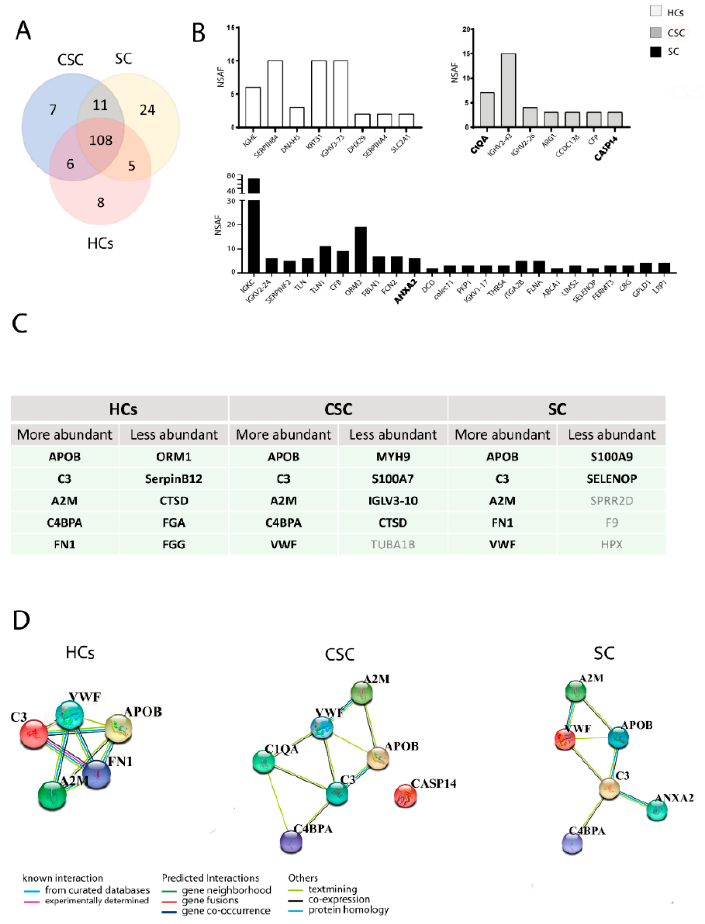
Figure 2. Significant proteins in the serum-derived EVs from healthy controls and patients with ischaemic stroke: ( A ) the distribution of detected proteins across the groups is represented by a Venn diagram; ( B ) the graphic represents the specific proteins found in each group. Proteins in bold have been validated in each group; ( C ) the table contains the more abundant and less abundant proteins in each group. Proteins in bold have been validated in each group; ( D ) interaction between the important proteins of each group (coloured nodes are query proteins and the first shell of